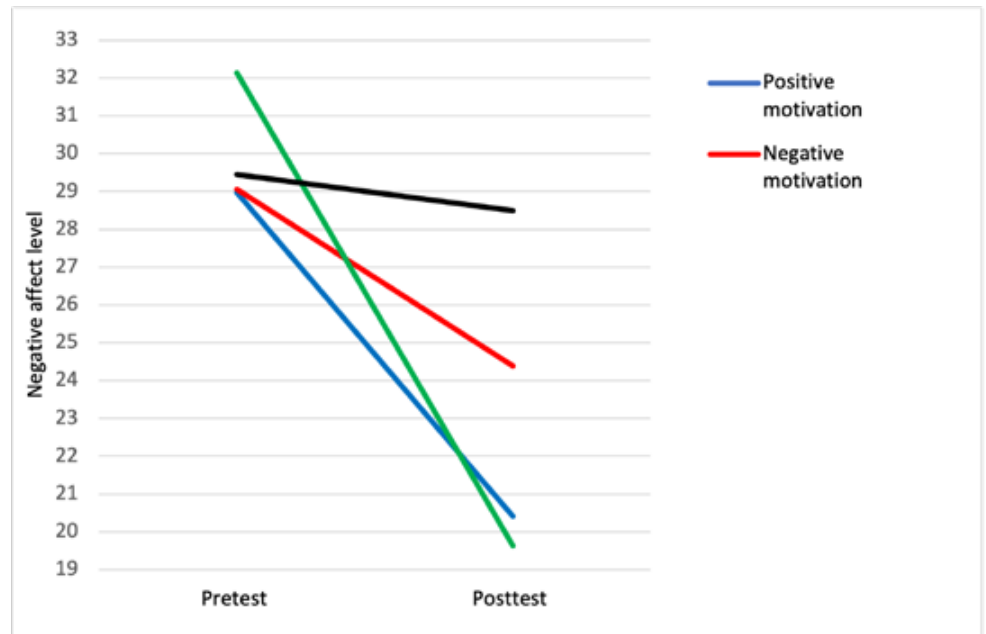
Figure 2. The negative affect mean scores in pretest and posttest of the four groups of students: positively motivated (PM)*, negatively motivated (NM)*, unmotivated group (UM)*, control conditions (CC). Significant differences between CC groups and experimental groups in posttest (p <0.001). Significant differences between NM and PM (p=0,017) and UM (p=0,004) in posttest. * Intra-group differences significant at the level of p